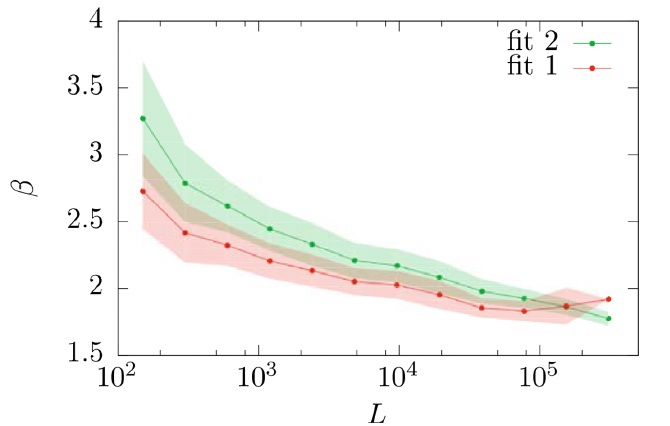
Fig 10. Mean value and standard deviation (represented by the shaded regions) of the distribution of the Zipf ’ s exponent β as a function of text length L for distributions f 1 and f 2 . Note that the last bin of f 1 contains a single datapoint, and so its standard deviation is not